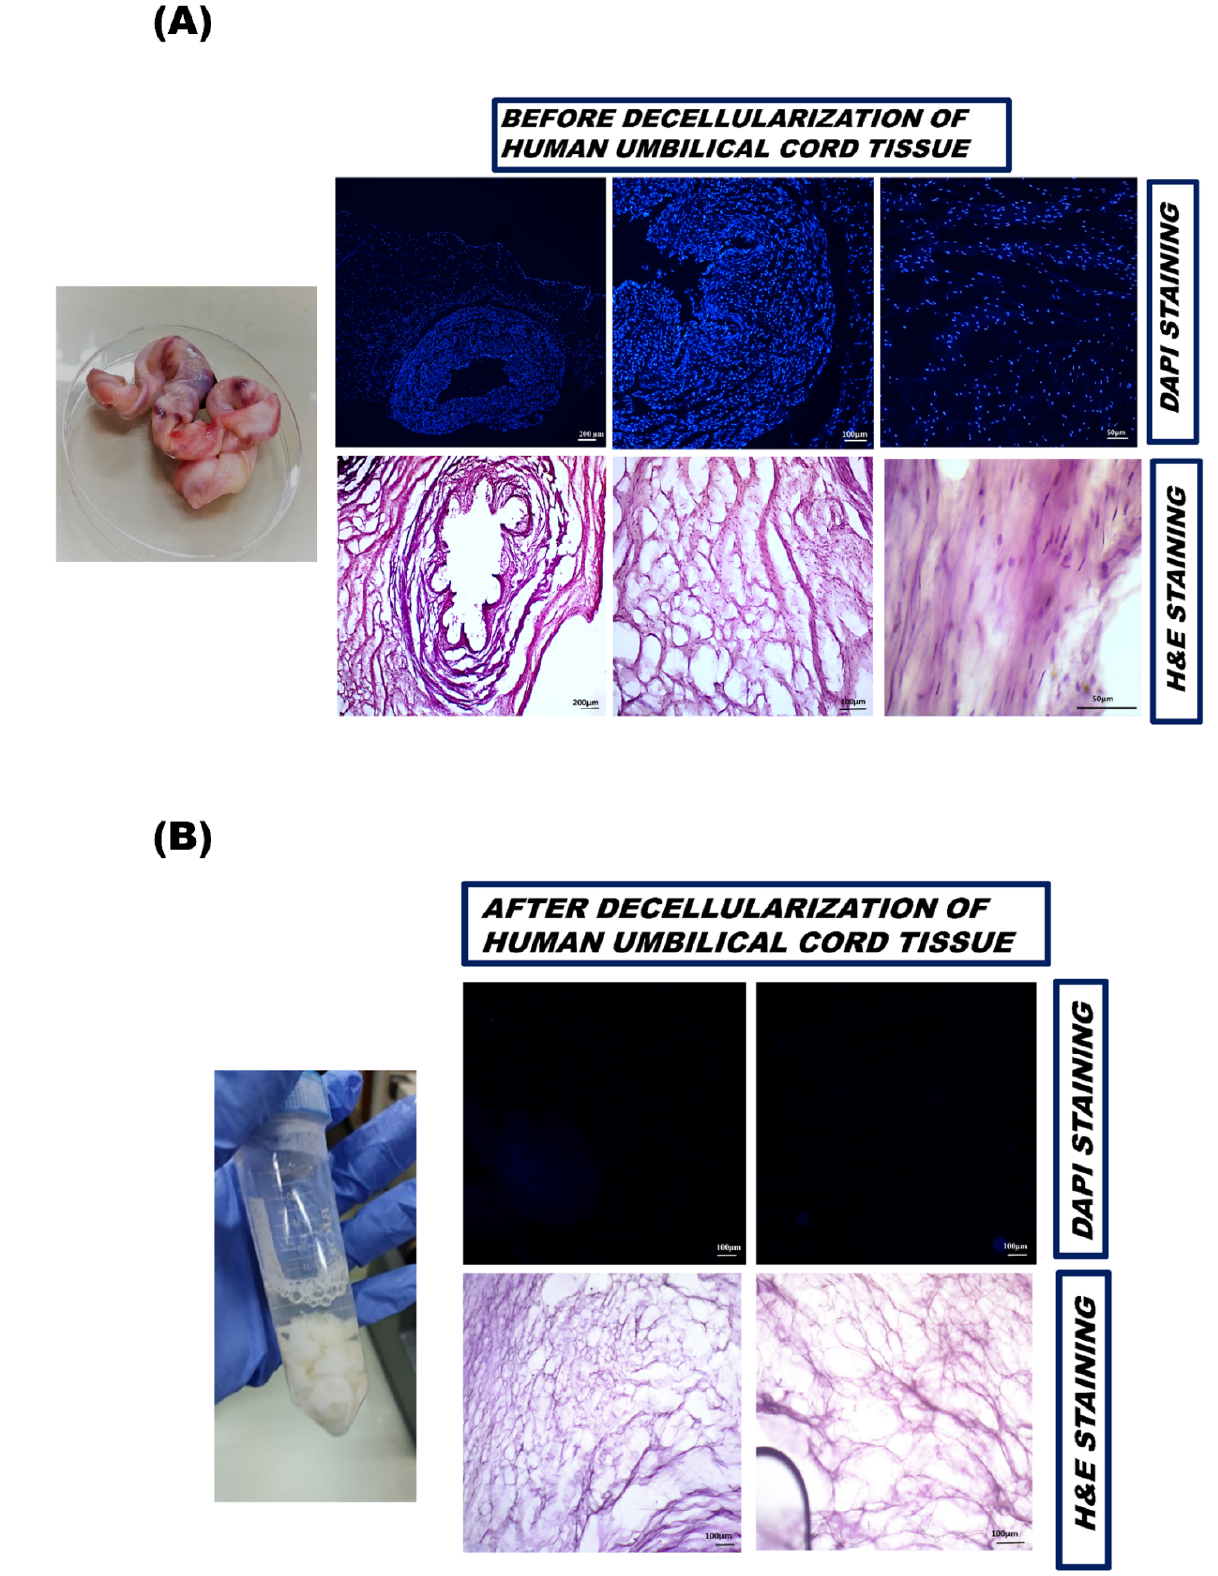
Figure 2. Histological analysis of nuclear content before and after decellularization of human umbilical cord tissue. ( A ) Histological analysis of nuclei in the native tissue was assessed by (DAPI) and (H&E) staining , ( B ) while no nuclei were observed in DUC tissue after decellularization.